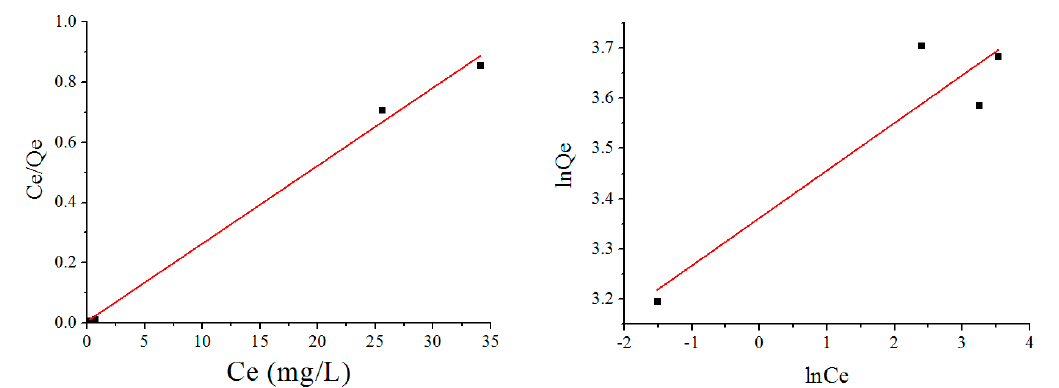
Figure 11. Langmuir adsorption isotherm ( left ) and Freundlich adsorption isotherm ( right ).